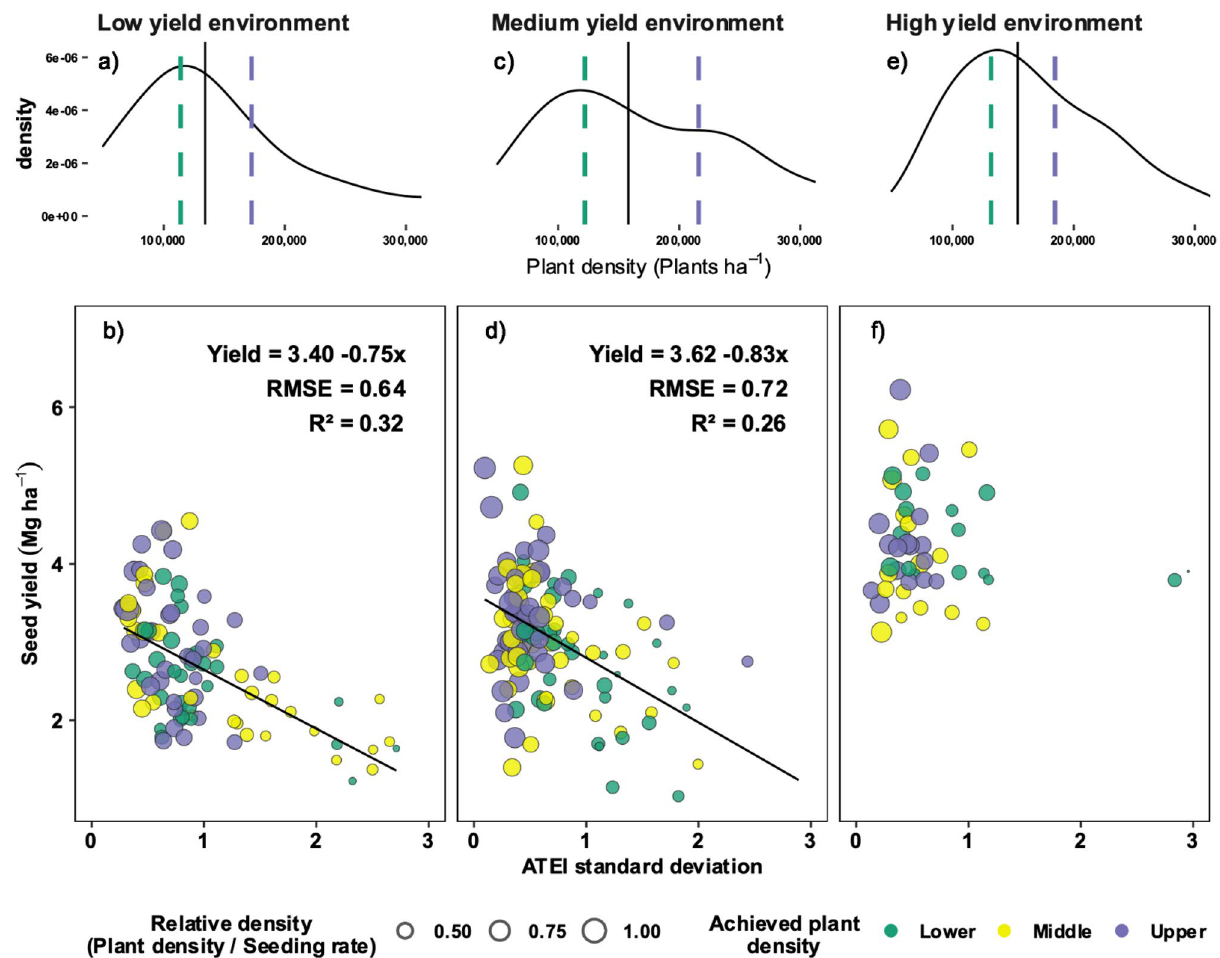
Figure 4. Relationship between soybean yield (Mg ha −1 ) and ATEI sd (achieved versus targeted evenness index standard deviation) in low- ( b , mean of 2.7 Mg ha −1 ), medium- ( d , mean of 3.0 Mg ha −1 ), and high- ( f , mean of 4.3 Mg ha −1 ) yield environments. The size of the bubbles indicates the relative density (plant density to seeding rate ratio), and colors indicate lower (red), middle (blue), and upper (green) thirds of achieved plant density distribution within each yield environment. Panels ( a ), ( c ), and ( e ) show the density distribution of the obtained plant density (plants ha −1 ) by yield environment, full line and dashed lines denotes the median, and lower– upper terciles, respectively. Yield environments are based on ANOVA of site-year versus yield (Supplementary Fig. 1). Interaction between ATEI sd and yield environment was significant (alpha = 0.05). R 2 coefficient of determination, RMSE root mean square